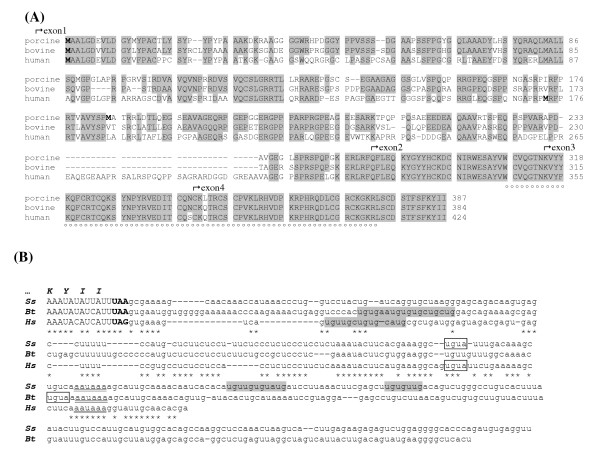
ZAR1 protein and mRNA sequences comparison between pig, cattle and human. (A) Alignment of porcine and bovine ZAR1 with human protein. Numbers indicate amino acid position. Identical amino acids are boxed in grey. Zinc finger, FYVE/PHD-type domain is underlined by circle points. Exon boundaries are defined by bent arrows. Start methionin amino acids (M) are in bold; note putative alternative start M sites in porcine (amino acid 183) and human (amino acid 173). (B) Porcine (Ss), bovine (Bt) and human (Hs) ZAR1 3'-- end cDNA alignment. 3-UTRs are in lower-case letters. Coding sequence is in capital letters. Termination codons are bold-typed. Identical nucleotides are denoted by stars. Protein sequence is in bold-type italic. Hexamer polyadenylation signals are double-underlined. Putative Pumilio-binding sites are outlined. U/purines dinucleotide-rich stretches (putative EDEN) are boxed in grey.